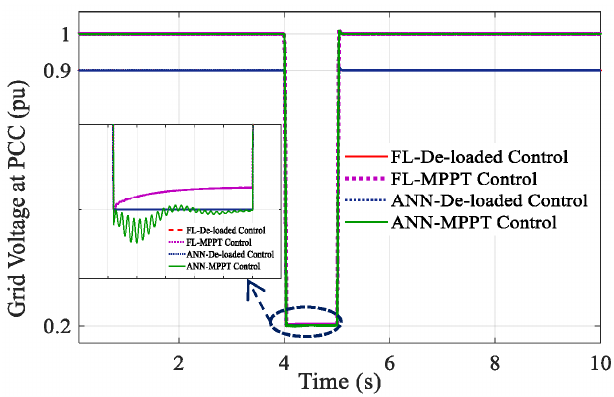
Figure 12. The voltage at PCC at the time of the grid-voltage sag.